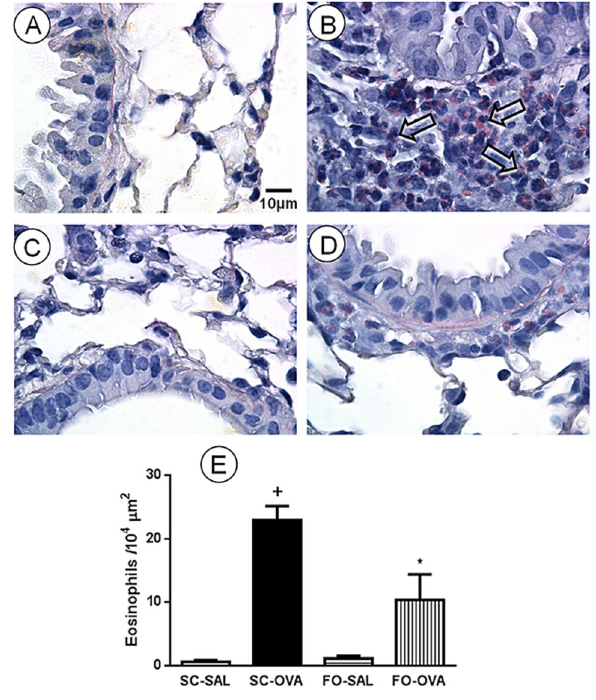
Figure 2. Effect of FO intake on allergen-evoked eosinophil lung tissue infiltration of A/J mice. Photomicrographs were taken of representative airways from (A) sensitized, saline-challenged (SC-SAL); (B) sensitized, ovalbumin-challenged (SC-OVA); (C) sensitized, saline-challenged with fish oil (FO-SAL) and (D) sensitized, ovalbumin-challenged with fish oil (FO-OVA). (E) Peribronchiolar eosinophil number was determined in lung sections by morphometric analyses. The analyses were performed 24 hours after the last challenge. Slides were stained with Sirius Red. Arrows indicate representative eosinophils. In the signaled cases, P <0.05 compared with the SC-SAL group (+) and the SC-OVA group (*) (one-way ANOVA and post-hoc Holm-Sidak test). Values are the means ± S.E.M. and are representative of 1 experiment (n=5 per